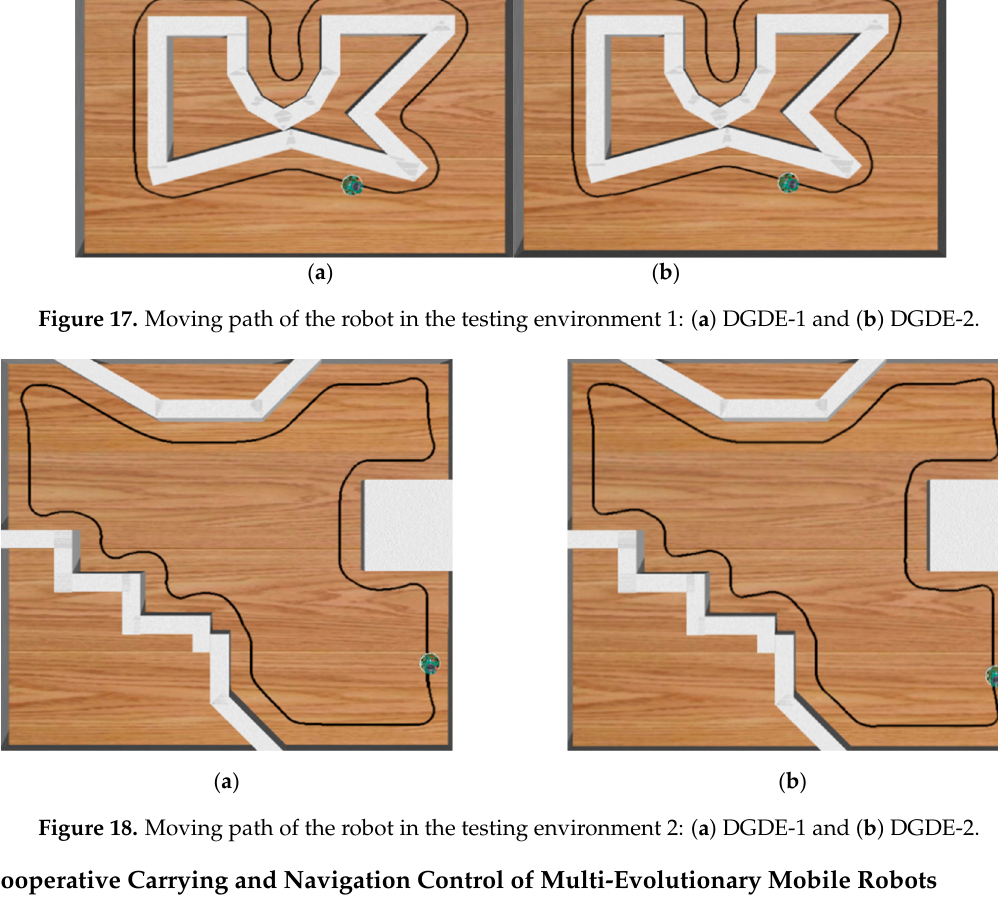
Figure 16. Moving path of the robot in the training environment: ( a ) DGDE-1 and ( b ) DGDE-2.